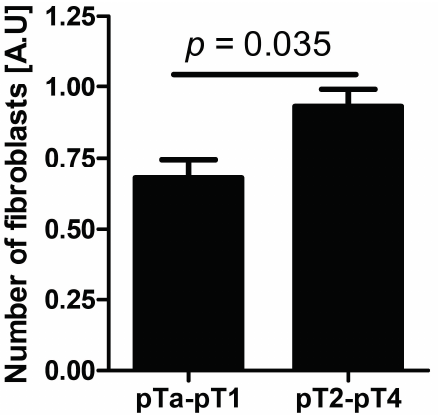
Figure 8. The number of cancer-associated fibroblasts in non-muscle-invasive bladder cancer (stages pTa, pTis, and pT1) and muscle-invasive bladder cancer (stages